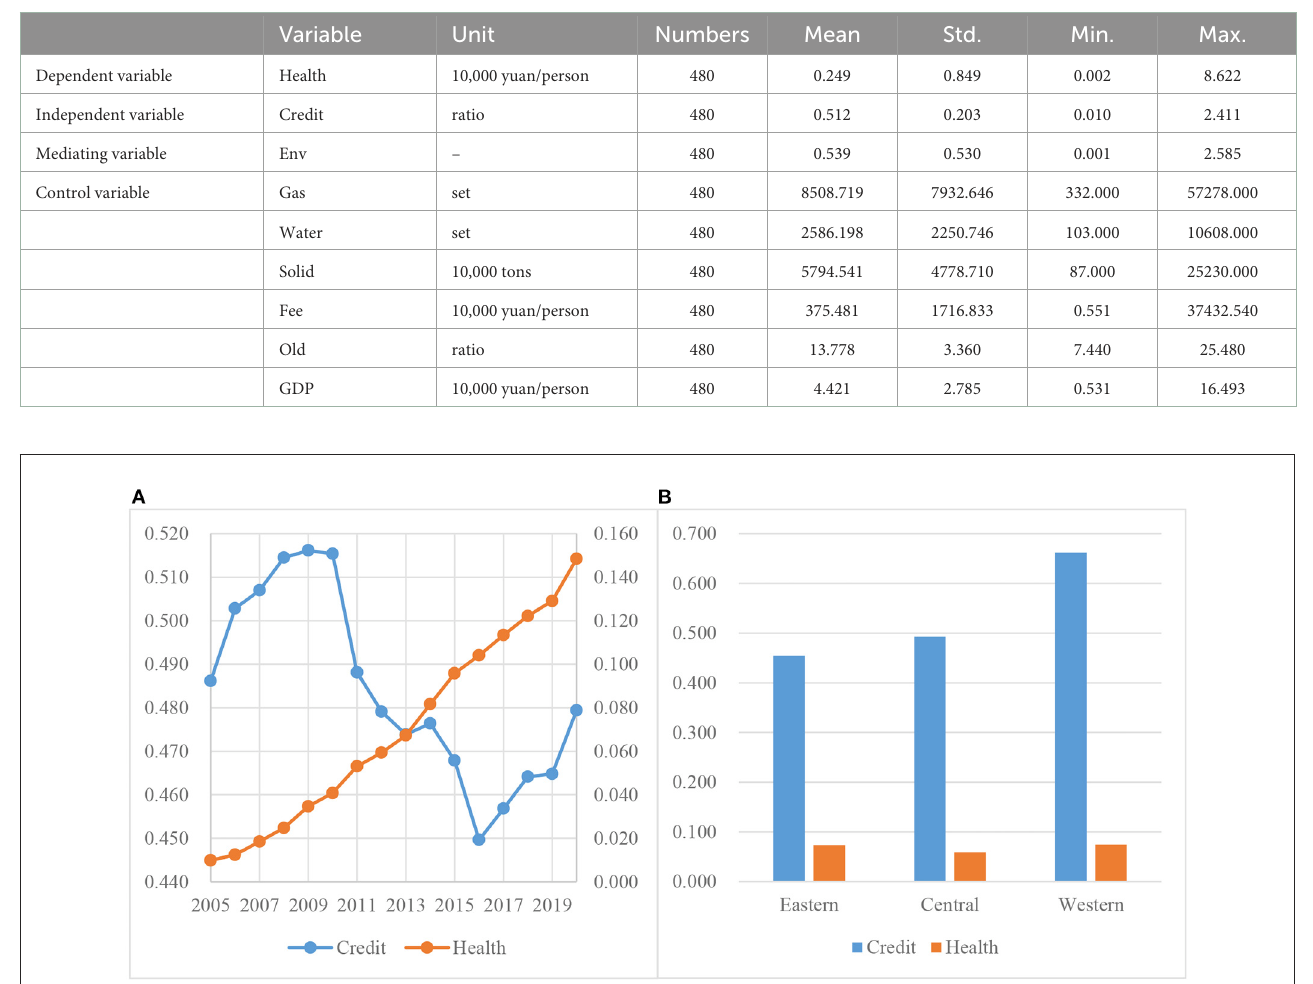
FIGURE1 (A, B) Trend and regional difference in credit and